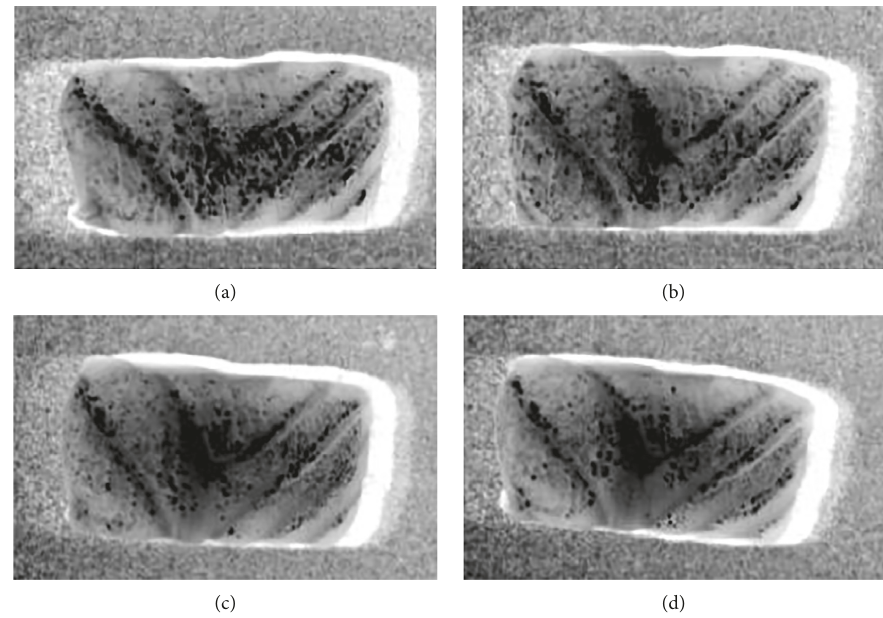
Figure 3: PC2 images of the salmon samples with (a) 0, (b) 0–0.2, (c) 0.2–0.4, and (d) 0.4–0.6 mL of water injected.